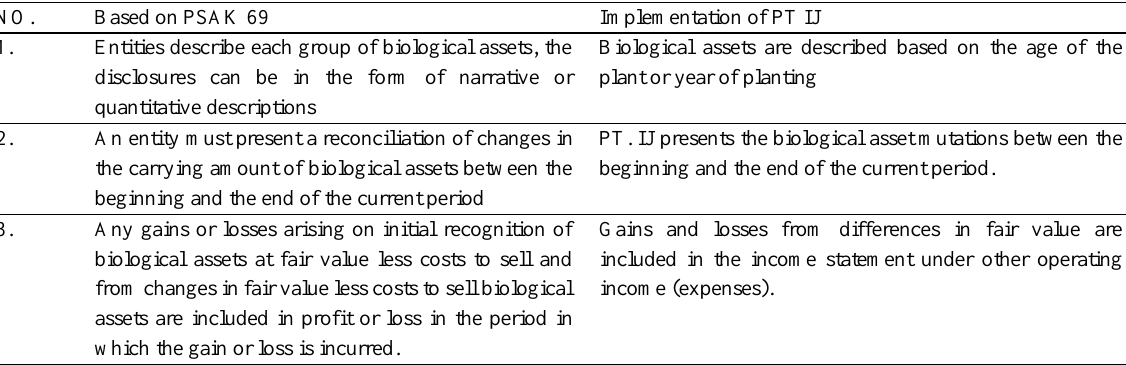
Table 6: Matrix of Presentation and Disclosure of Agricultural